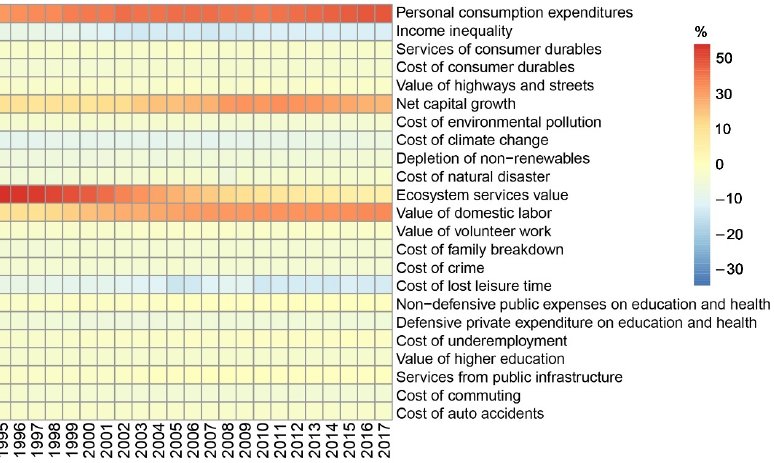
Figure 5. Contribution changes of social, economic, and ecological indicators to total GPI from 1995 to 2017.